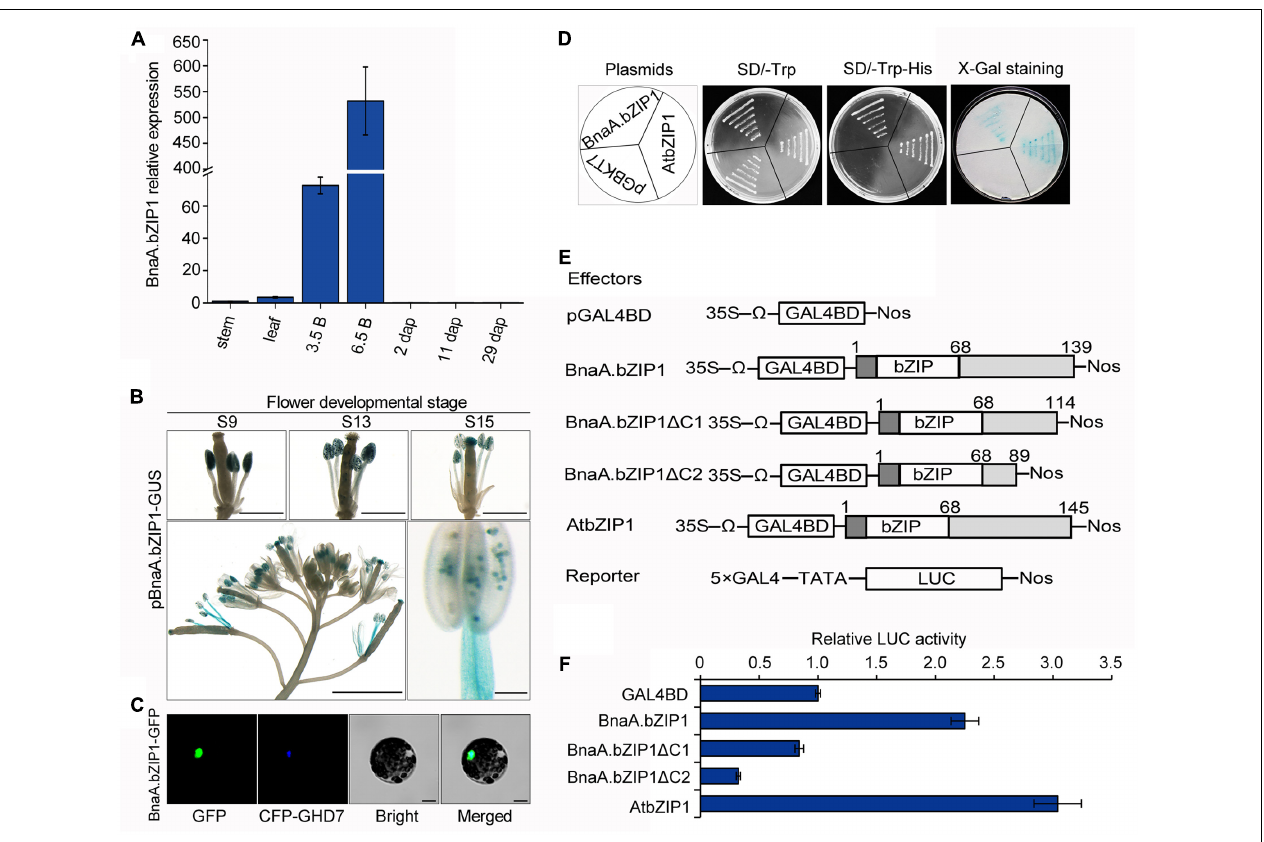
FIGURE 4 | Expression pattern, subcellular localization, and the transcriptional activation activity of BnaA.bZIP1. (A) Expression levels of BnaA.bZIP1 in diverse tissues as assessed by qRT-PCR. Error bars indicate the SD and were calculated from three biological replicates. 3.5B, 0–3.5 mm buds; 6.5B, 3.5–6.5 mm buds; the other tissues are as mentioned in Figure 1C . (B) GUS expression in developing flower of pBnaA.bZIP1 transgenic lines. Bars, 500 µ m (flower buds), 1 mm (whole inflorescence), and 100 µ m in the case of stamen. (C) Subcellular localization of BnaA.bZIP1. The fusion plasmid (pM999-BnaA.bZIP1-GFP) and a nuclear marker plasmid (pM999-CFP-GHD7) were co-transformed into Arabidopsis protoplasts. Scale bars = 10 µ m. (D) Assay for the transcriptional activation of BnaA.bZIP1 in yeast cells. The pGBKT7-AtbZIP1 and pGBKT7 were used as positive and negative controls, respectively. (E) Schematic diagrams of the constructs used for the transient expression assay in Arabidopsis protoplasts. The full-length and two C-terminal deletions of BnaA.bZIP1 were fused with GAL4BD. The pGAL4BD and pBD-AtbZIP1 were used as negative and positive controls, respectively. (F) The transcriptional activation abilities of effectors were determined by the ratio of LUC to REN, which was obtained from the co-transformation of protoplasts with the effector and reporter plasmids ( n = 3). The value of the negative control was set to 1. Error bars represent the SE of three biological